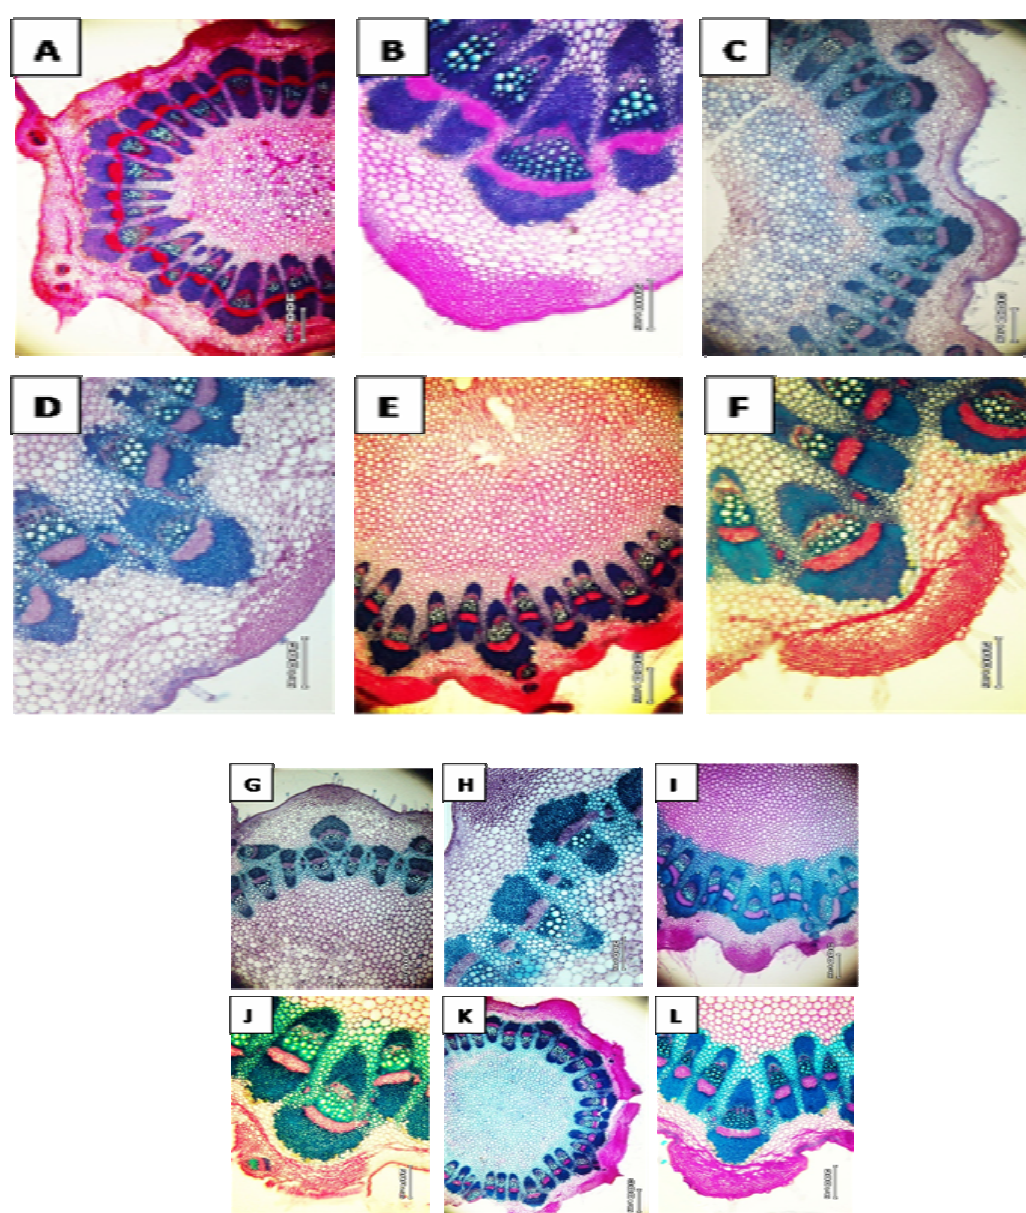
Fig. 8. Cross section of stem in Onopordum species: (A-B): O. acanthium; (C-D): O. carduchorum; (E-F): O. leptolepis; (G-H): O. carmanicum ; (I-J): O. heteracanthum ; (K-L): O. armenum. (Scale bar=200 µm; B, , F, H, J, L; X= 40; (A, C, E, G, I, K: X= 20) Pollen characters: All taxa had 3-zonocolporate pollen grains and Amb were rounded triangular or 3-lobate and elliptic equatorial view. According to P/E ratio;